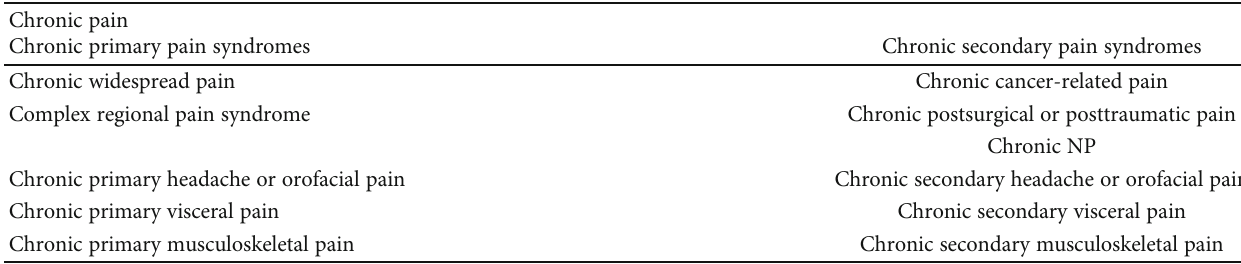
Table 1: The IASP classi fi cation of chronic pain [35].